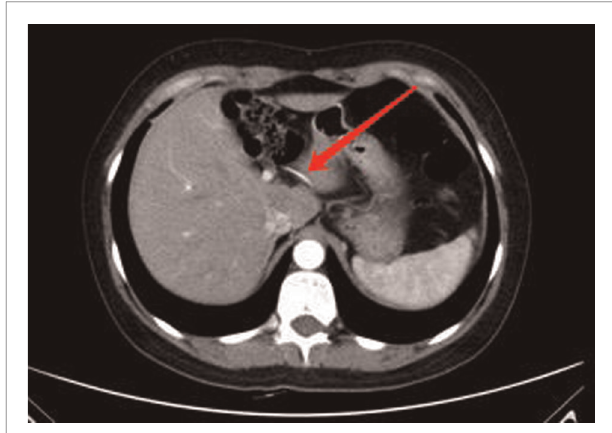
FIGURE 1 | Computed tomography scan showing a hyperdense linear foreign body (red arrow) embedded in the liver.